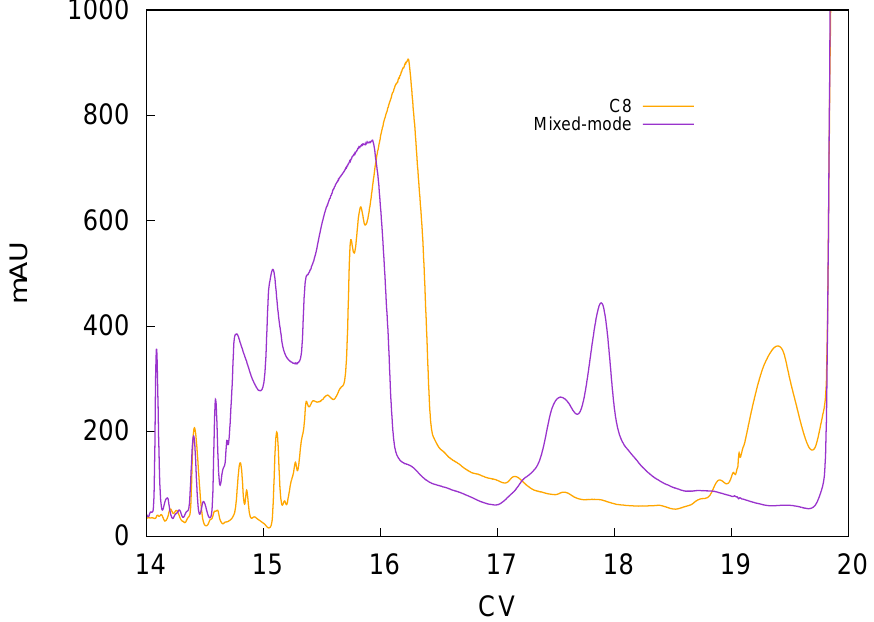
Figure 2. Comparison between chromatographic profiles obtained with C8 (orange) and mixed-mode (violet) columns. The main peak and other species elute earlier because of the repulsive effects established between doping ligands and the feed components, both negatively